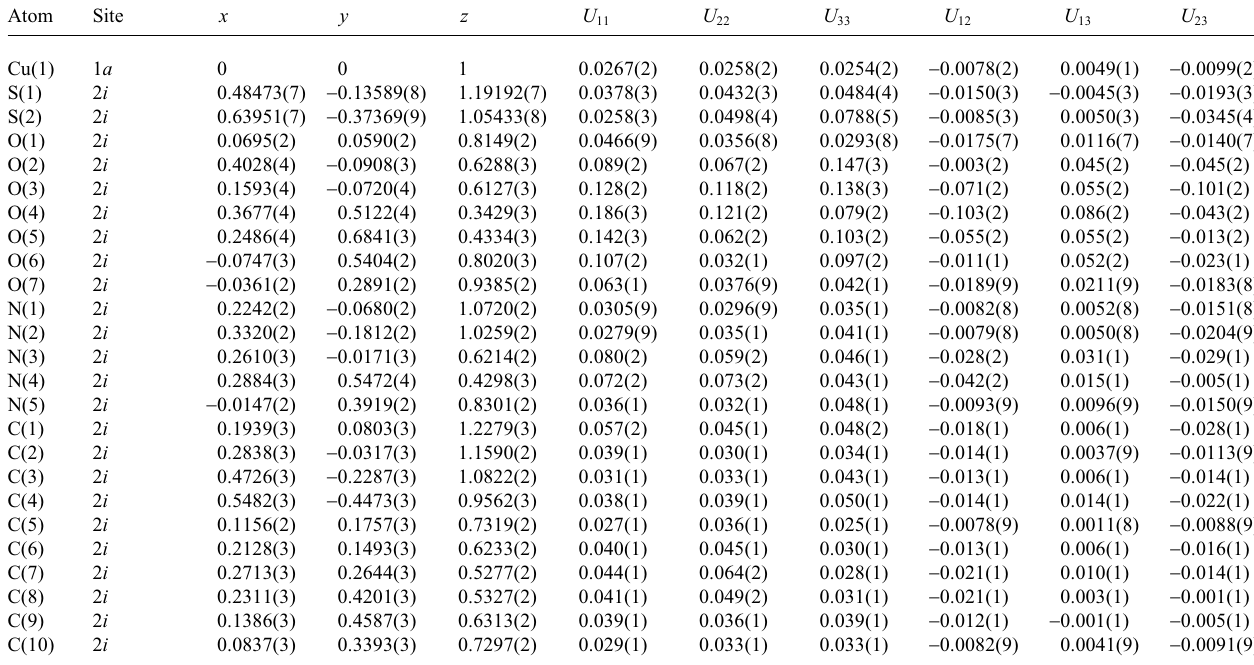
Table 3. Atomic coordinates and displacement parameters (in Å 2